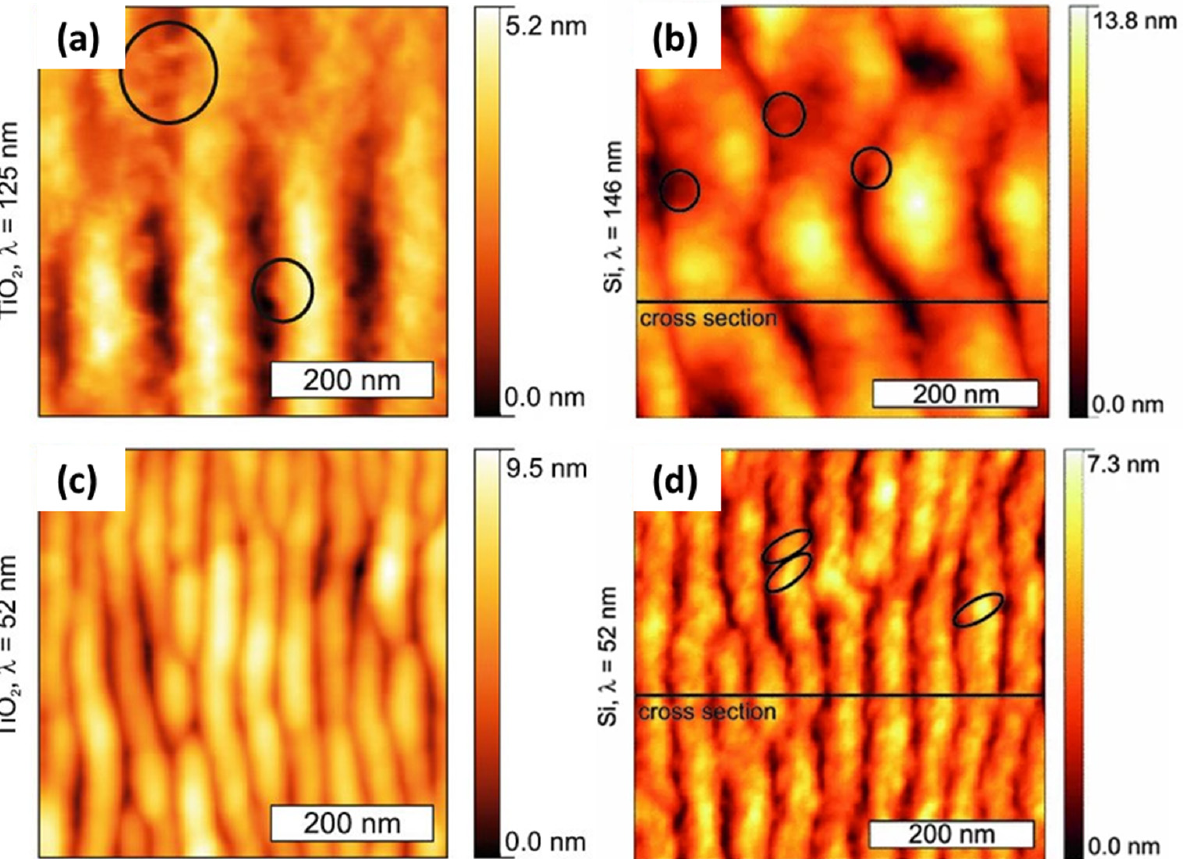
Figure 4. AFM images of nanorippled TiO 2 ( a , c ) and oxidized Si surfaces ( b , d ) after HPF adsorption. Pattern periodicities are ( a ) 125 nm, ( b ) 146 nm, ( c ) 52 nm, and ( d ) 52 nm. The black circles indicate adsorbed HPF molecules. Adapted from Ref. [106].